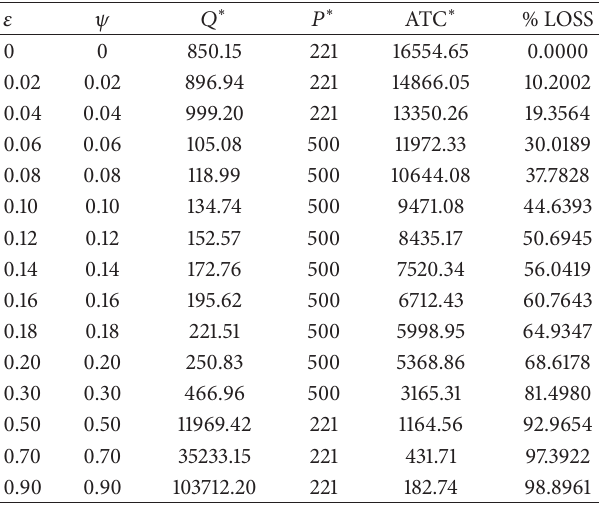
Table 3: Optimal solutions for different values of 𝜀 and 𝜓